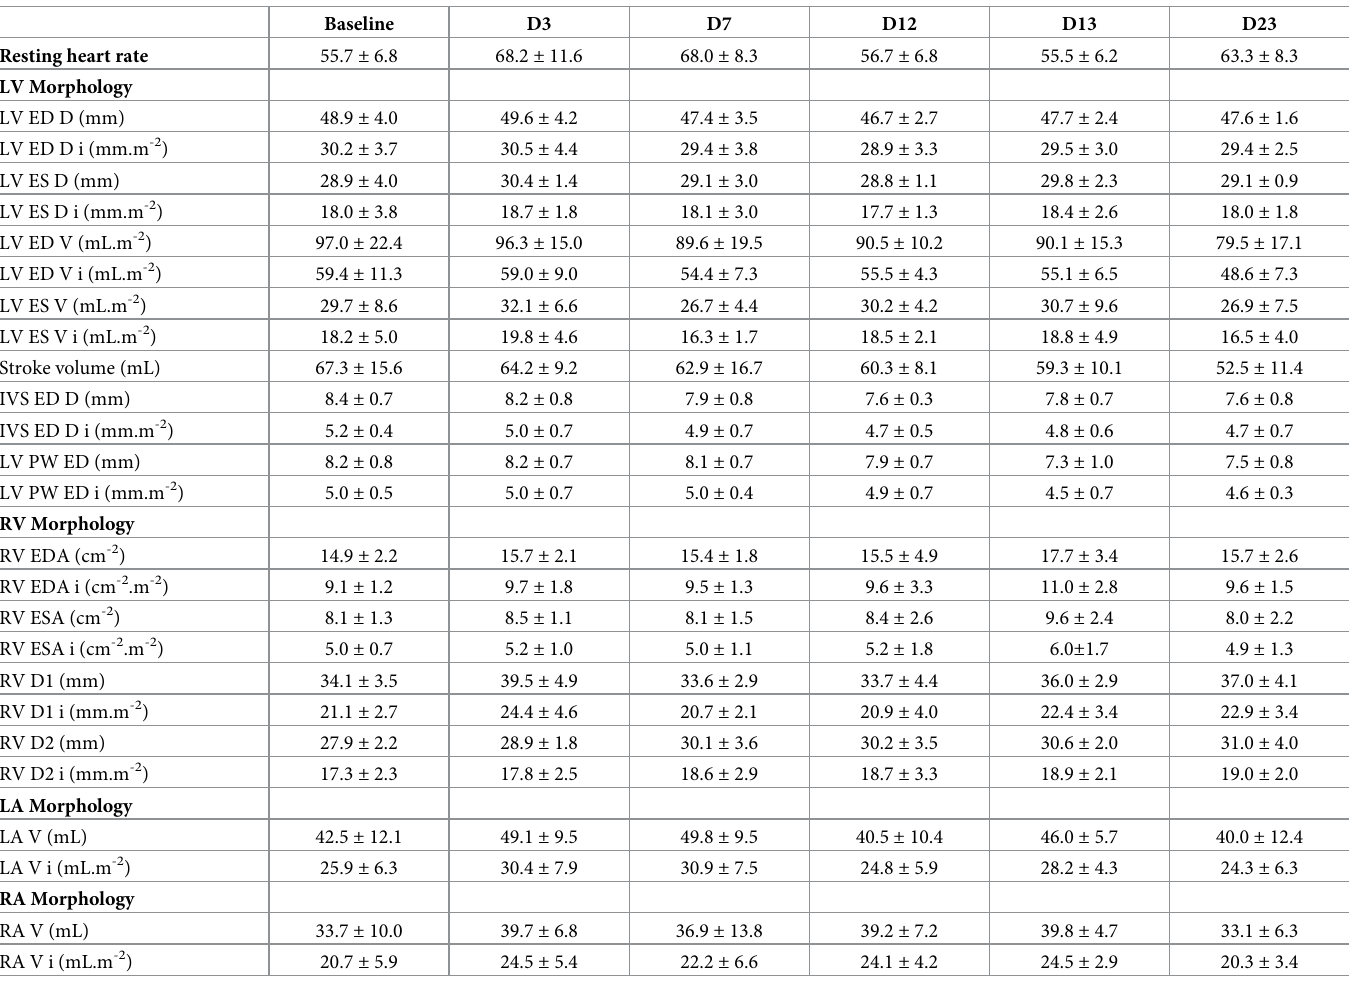
Table 4. Rest cardiac dimensions measured by echocardiography.